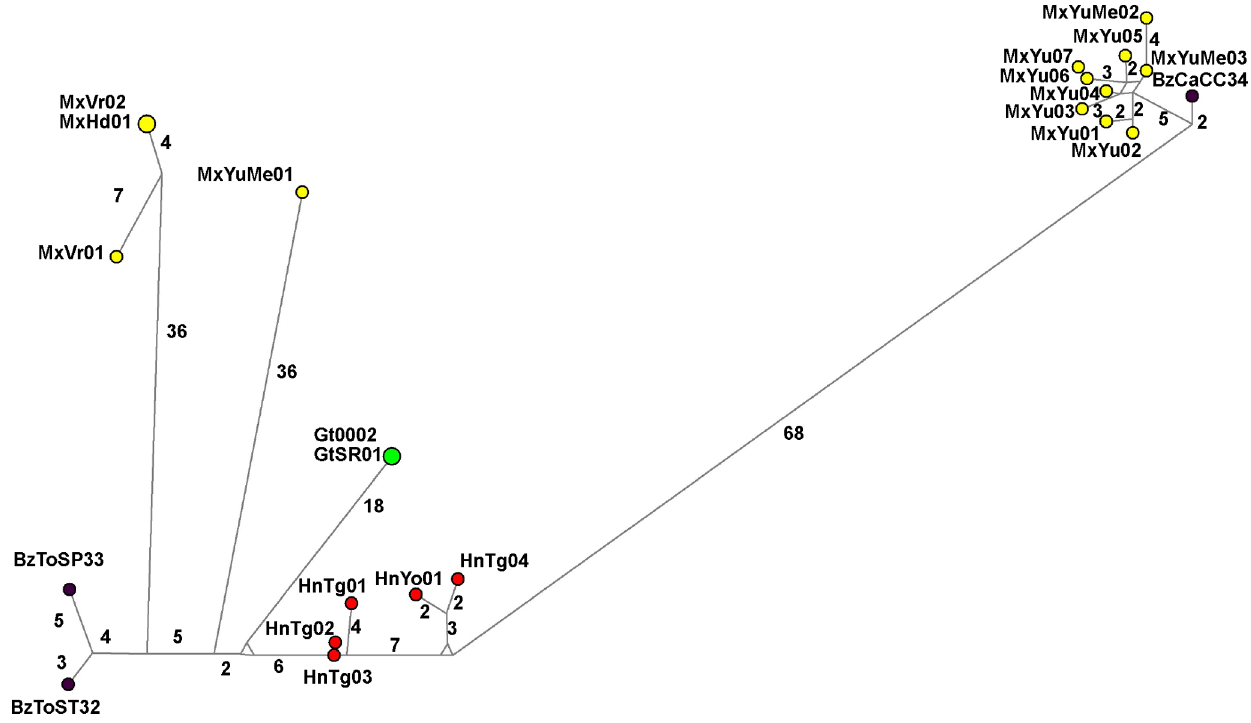
Figure 4. Network analysis of all 22 haplotypes of T.dimidiata mt cytb . The size of the circle indicates how many individuals shared that haplotype. The colors indicate the country of the sample: Mexico-yellow, Honduras-red, Guatemala-green, Belize-black.